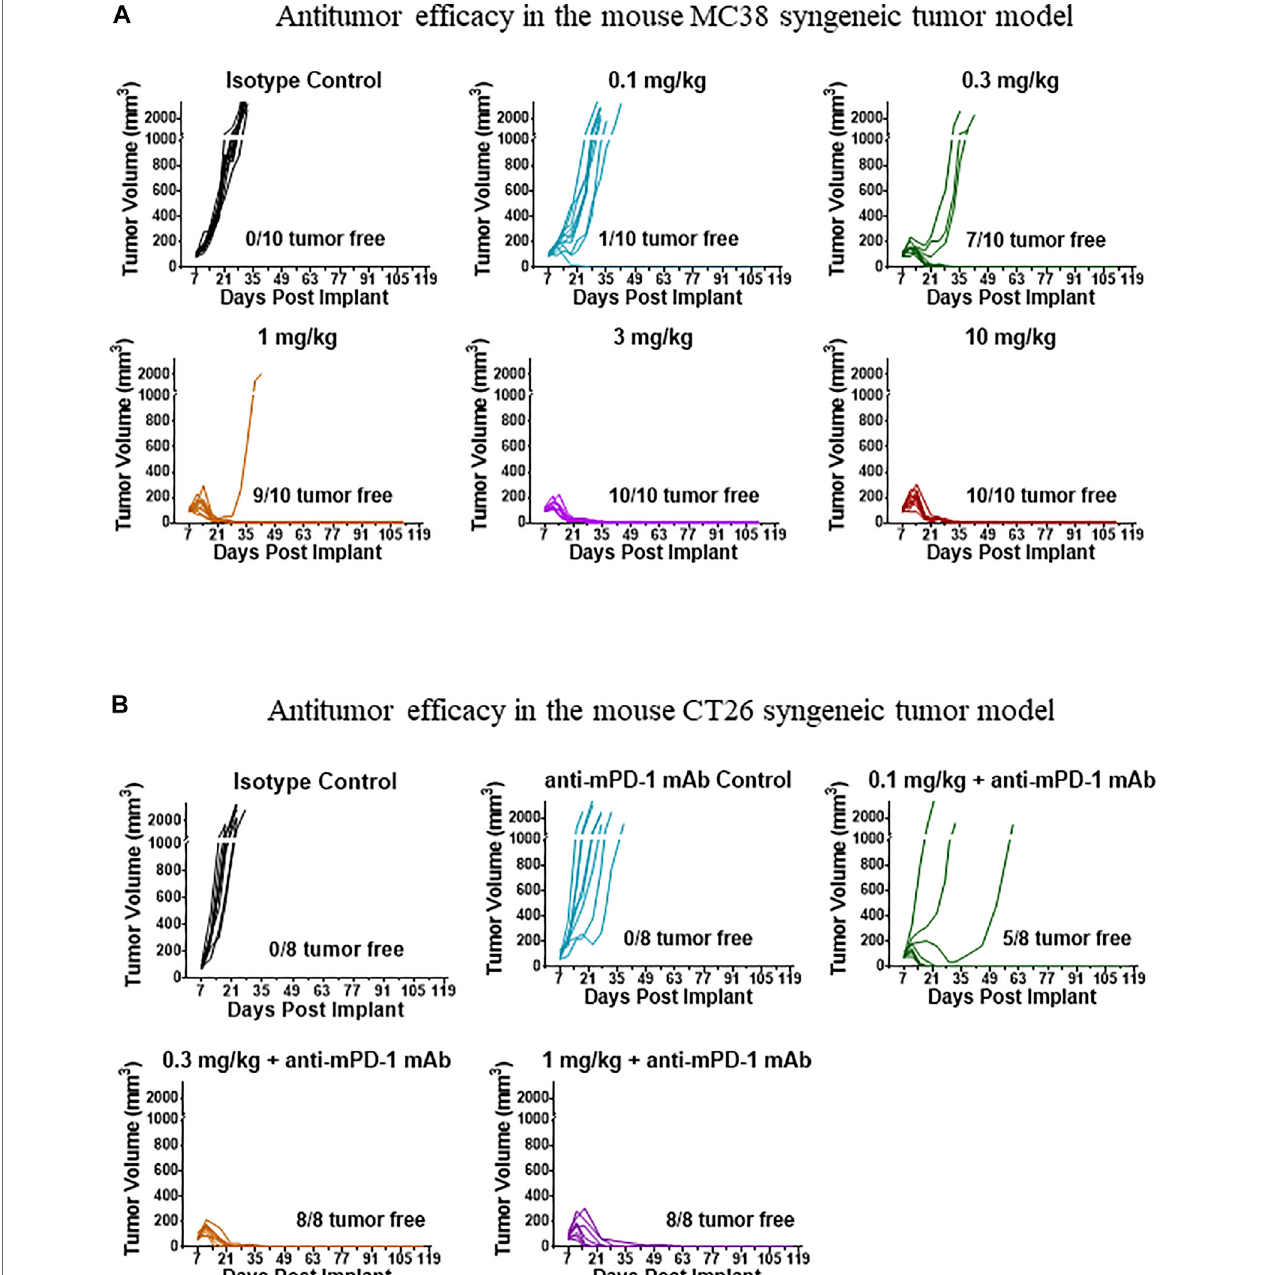
FIGURE2| Representativetumorgrowthcurvesintumor-bearingmicetreatedwithmFc-mIL-10. (A) MC38syngeneictumormodelwheremFc-mIL-10wasgiven a single intraperitoneal injection at doses of 0.1, 0.3, 1, 3, and 10 mg/kg; (B) CT26 syngeneic tumor model where mFc-mIL-10 was injected intraperitoneally at a single dose of 0.1, 0.3, and 1 mg/kg in combination with a mouse anti-mouse programmed death-1 monoclonal antibody that was dosed at 10 mg/kg once every 4 days for 3 doses.